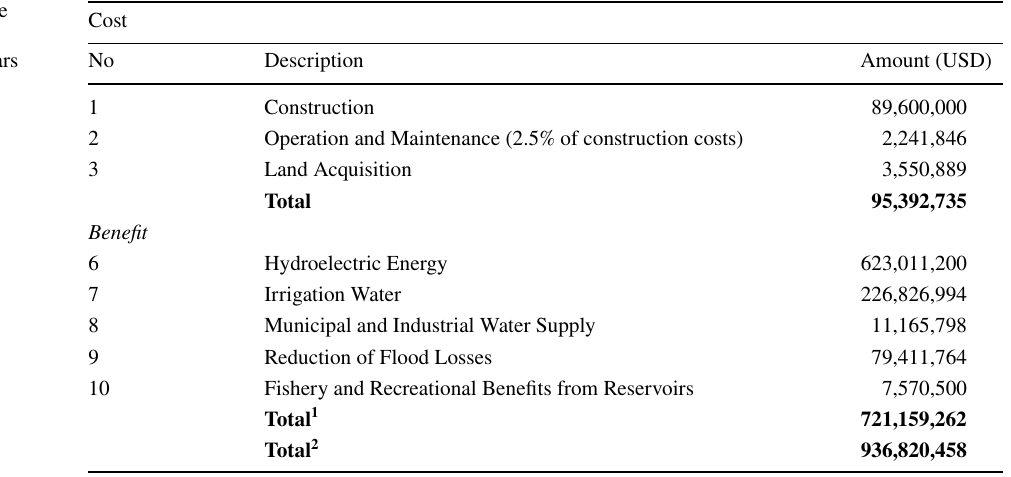
The decision-makers should consider using surplus water for the irrigation or water supply. Total 1 is the benefits for the developing water supply system case and total 2 is the benefit in case of agricultural